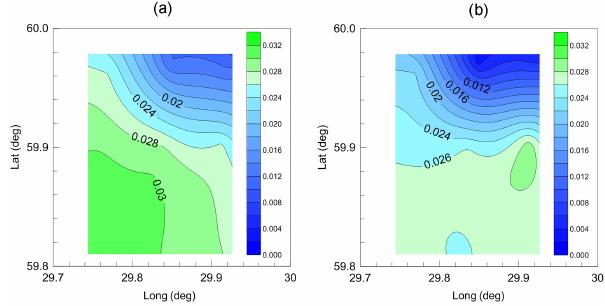
Figure 4. The scatter plots of LWP data contained in different HAT- PRO data sets; see Table 1. Panel (a) illustrates the influence of the sampling interval and (b) illustrates the influence of the averaging